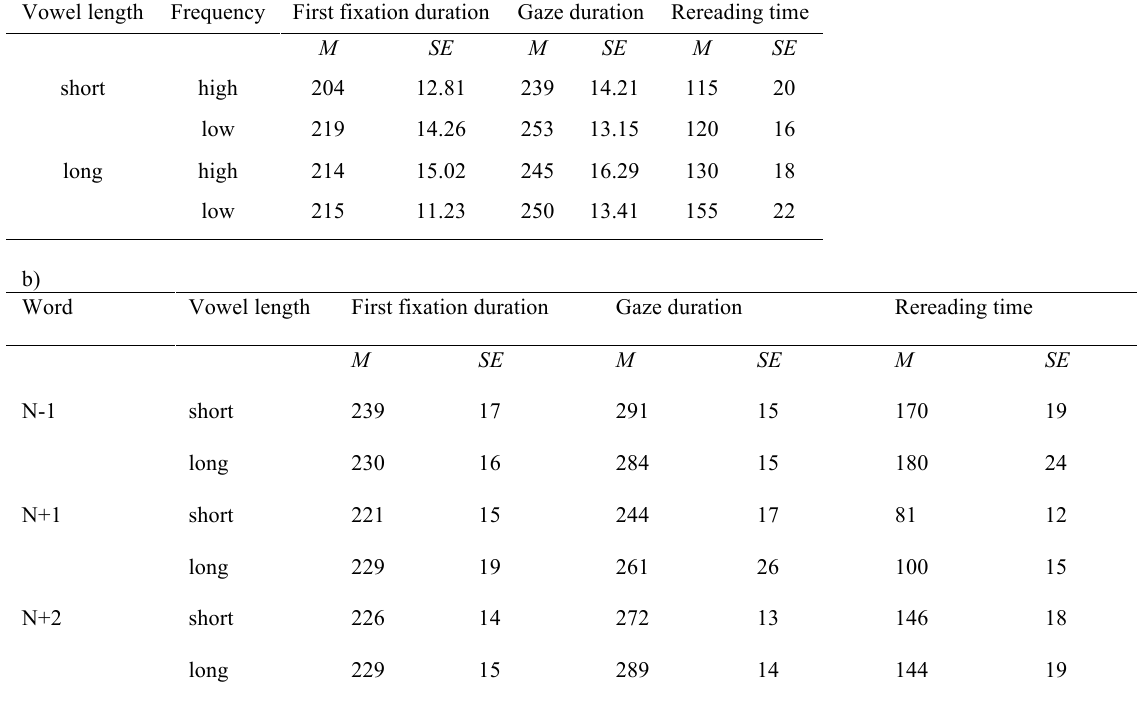
Mean first fixation durations, gaze durations, and rereading time in Experiment 2, a) on target words with short vs. long vowels and of high vs. low frequency, b) on surrounding words as a function of target word vowel